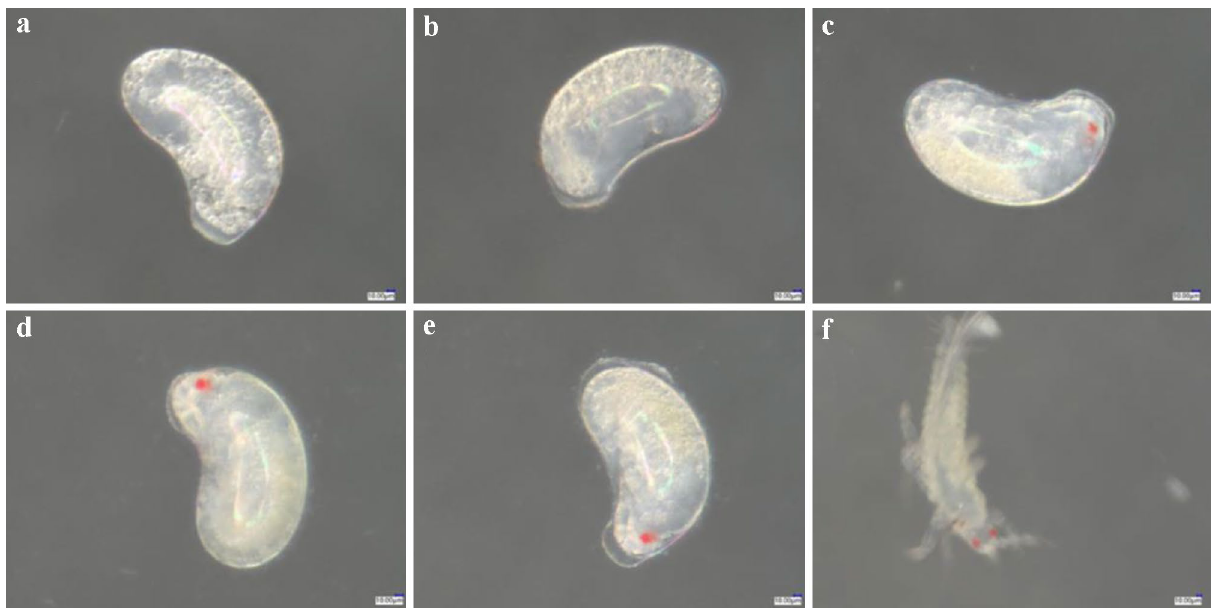
Figure 12. 24-h-old eggs embryo development of F. occidentalis in control treatment. ( a ) Control 24-h-old eggs; ( b ) eggs after 12 h of development; ( c ) eggs after 24 h of development; ( d ) eggs after 36 h of development; ( e ) eggs after 48 h of development; ( f ) eggs hatching as larvae after 60 h of development.